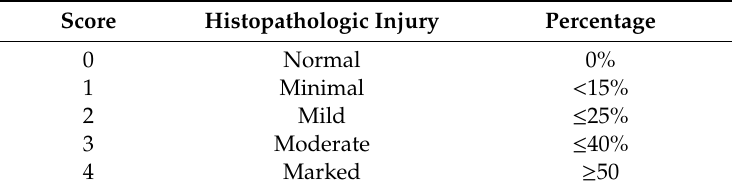
Table 1. Scoring system used in histological analysis on longissimus thoracis et lumborum muscle of goats supplemented with naturally produced lovastatin. Score Histopathologic Injury Percentage 0 Normal 0% 1 Minimal < 15% 2 Mild ≤ 25% 3 Moderate ≤ 40% 4 Marked ≥